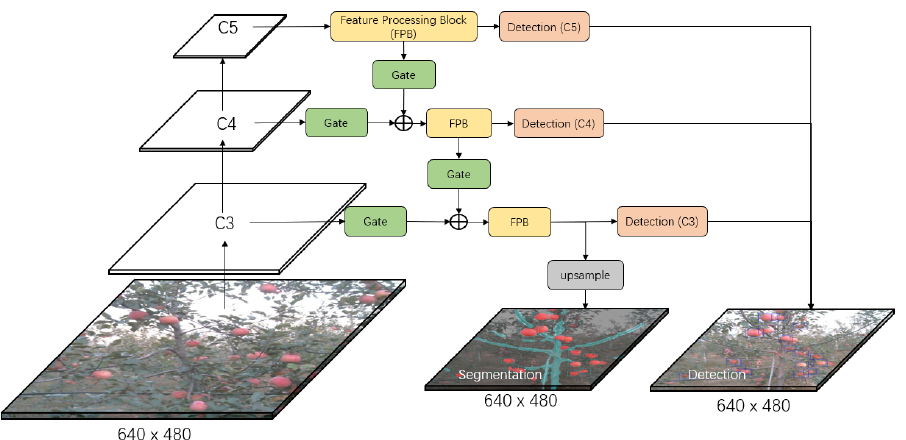
Figure 2. The architecture of DaSNet-A model. DaSNet-A has the common GFPN and the feature processing block for processing of detection and segmentation tasks. The output of the feature processing block in C3 level is upsampled to the original image size to generate the semantic segmentation